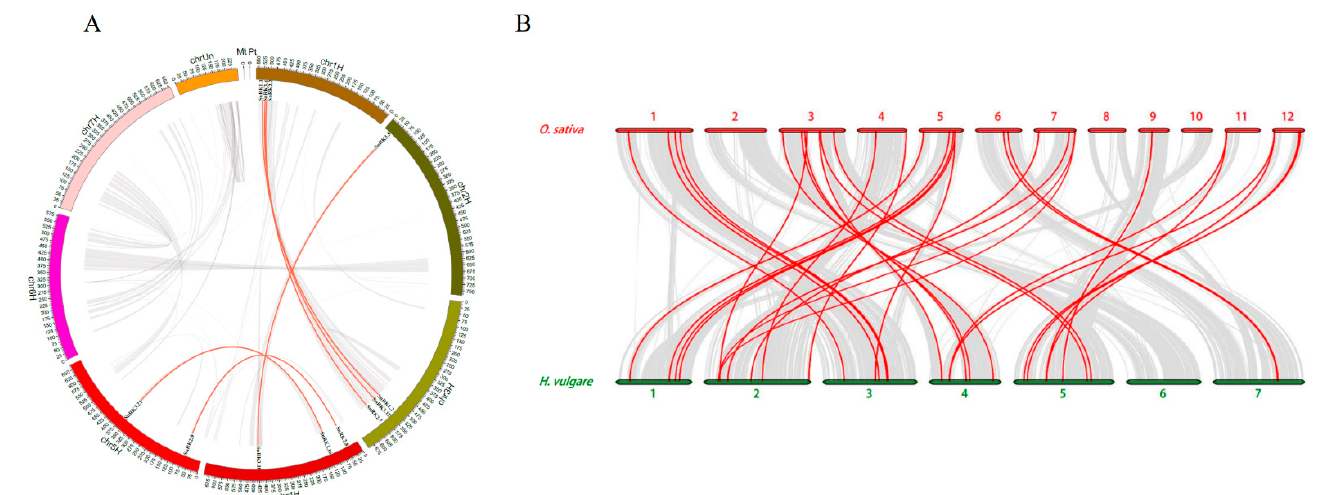
Figure 5. The synteny analysis of HvSnRK genes. ( A ) The synteny analysis of HvSnRK genes in barley genome. Gray lines: all synteny blocks in the H.vulgare genome. Red lines: duplicated HvSnRK gene pairs. ( B ) Synteny analysis of SnRK genes between the genomes of O. sativa and H. vulgare . Gray lines: all collinear blocks within O. sativa and H. vulgare . Red lines: the synteny of SnRK genes between O. sativa and H. vulgare.